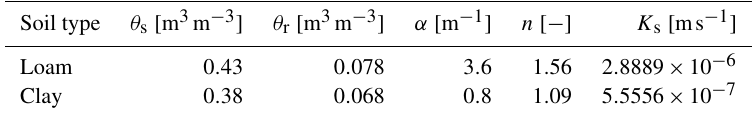
Table C3. Hydraulic properties of the loam layer and clay layer in Bonan (2019) for the numerical experiment on Dunnian runoff due to water table rising.